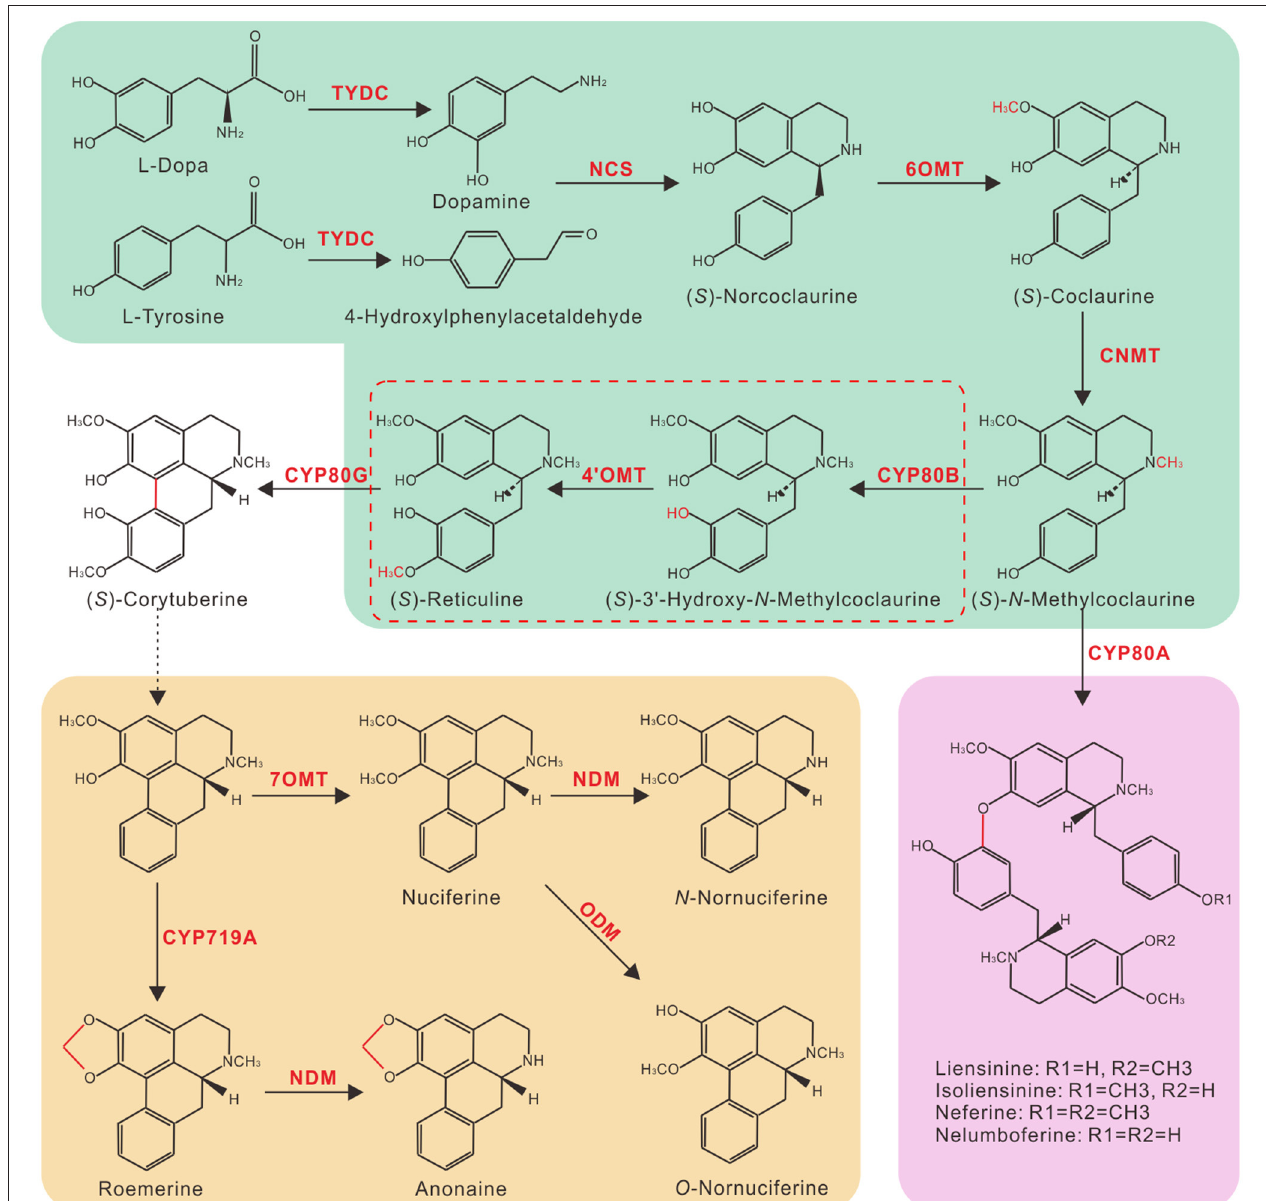
FIGURE 1 | Putative benzylisoquinoline alkaloid biosynthesis (BIA) pathway in lotus. Branch pathways are shown in colored boxes: green, common steps to ( S )-Reticuline; brown, aporphine alkaloids in lotus leaves; and purple, bis-benzylisoquinoline alkaloids in lotus embryos. Solid arrows indicate single-step reactions, dotted arrow indicates multiple steps, and the dotted box indicates possible redundant enzymatic steps in lotus. TYDC, tyrosine/DOPA decarboxylase; NCS, ( S )-norcoclaurine synthase; 6OMT, ( S )-norcoclaurine 6- O -methyltransferase; CNMT, ( S )-coclaurine N -methyltransferase; CYP80B, ( S )- N- methylcoclaurine 3 ′ -hydroxylase; 4 ′ OMT, ( S )-3 ′ -hydroxy- N -methylcoclaurine 4 ′ - O -methyltransferase; NDM, N -demethylase; ODM, O - demethylase.